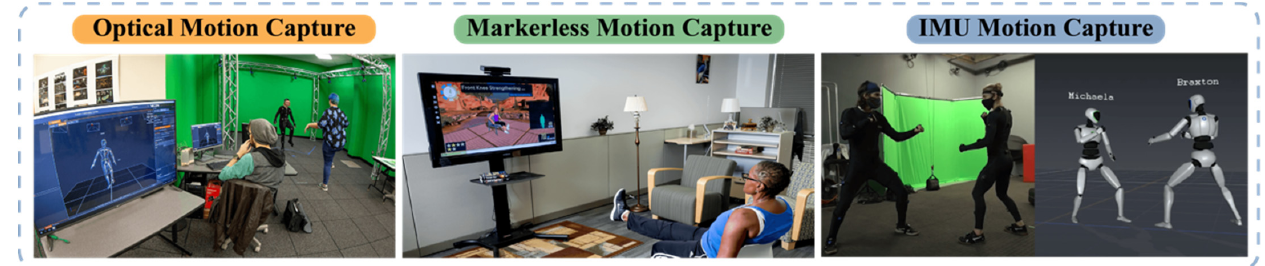
Figure 2. Three types of motion capture.